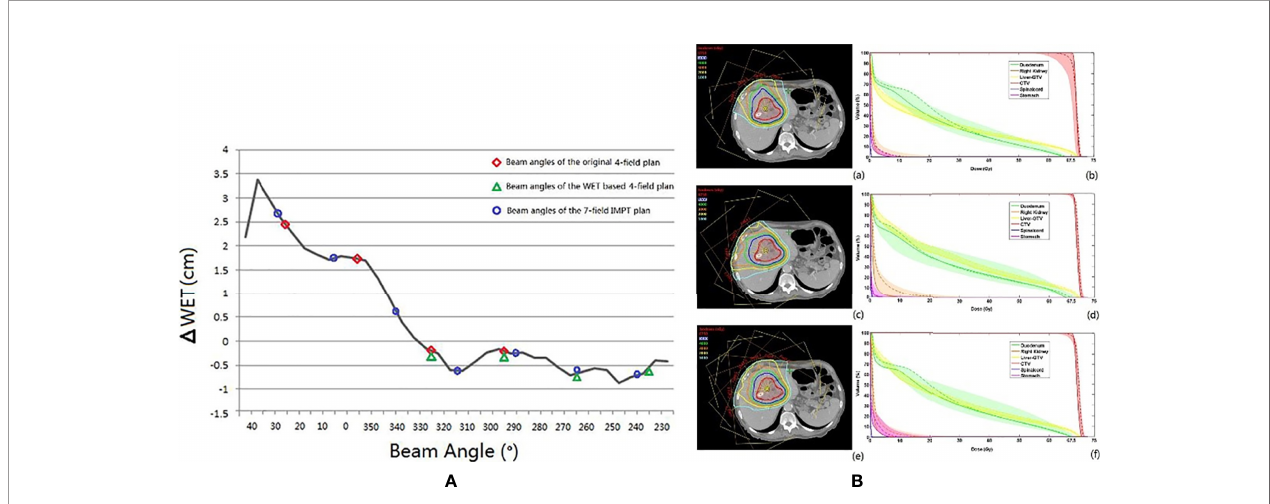
FIGURE 6 | (A) The black line is the D WET (the difference of water equivalent thickness between the planning CT and the CT-on-rail) curve. The beam angles of the original IMPT plan (25°, 355°, 325°, and 295°), the WET-based four fi elds plan (325°, 295°, 265°, and 235), and the revised seven fi elds plan (30°, 5°,340°, 315°, 290°, 265°, and 240°) are indicated with the red circle, the green triangle, and the blue circle, respectively. (B) The axial view of the same planar doses and fi elds for (a) the original IMPT plan, (c) the IMPT plan with beam angles of the minimum values of D WET, and (e) the seven- fi eld IMPT plan. The dose – volume histograms of the planned dose (solid line), the accumulated dose (dashed line), and the bands for all fractional doses of (b) the original IMPT plan, (d) the IMPT plan with beam angles of the minimum values of D WET, and (f) the seven- fi eld IMPT plan (49) (Source: Elsevier. Used with